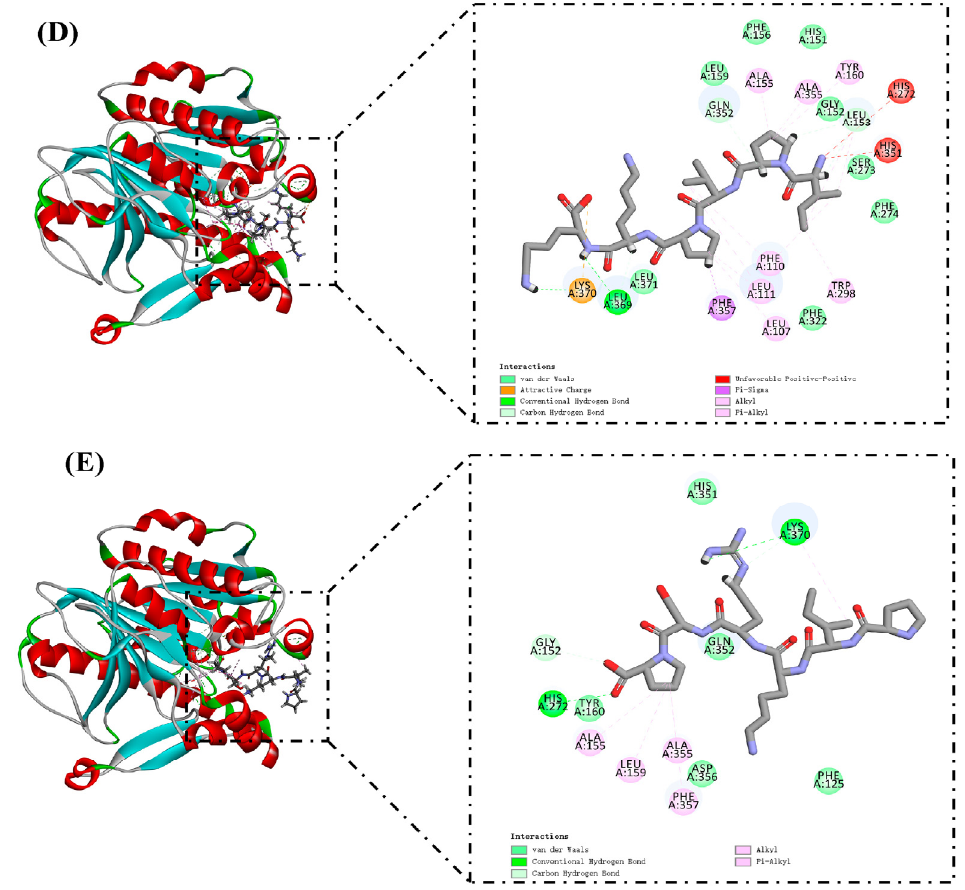
Figure 4. Molecular docking of peptides LTDKPFL ( A ), VEAPPAKVP ( B ), KVPVPAPK ( C ), IPVPKK ( D ), and PIKRSP ( E ) with PAF-AH.